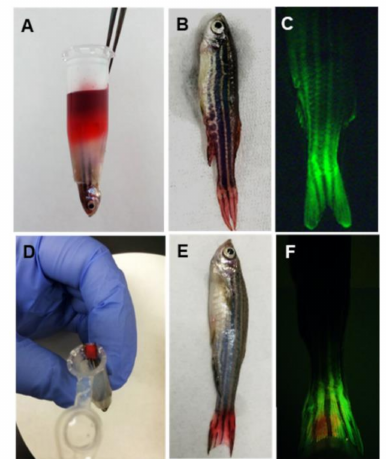
Figure 1. Leakage test after transdermal administration. ( A ) Transdermal administration of 100 µ L of felbinac-red dye solution for 2 h; ( B ) zebrafish released from agarose gel and washed with water three times after the transdermal administration of liquid solution; ( C ) fluorescent image of the zebrafish transdermally administered with 100 µ L of 4-[4-(diethylamino)styryl]- N -methylpyridinium iodide (4-DI-2-ASP) solution for 2 h; ( D ) the zebrafish administered with felbinac-red dye coating filter paper for 2 h; ( E ) the zebrafish released from the agarose gel and washed with water three times after transdermal administration of coating; ( F ) fluorescent image of the zebrafish transdermally administered with a 4-Di-2-ASP coating for 2